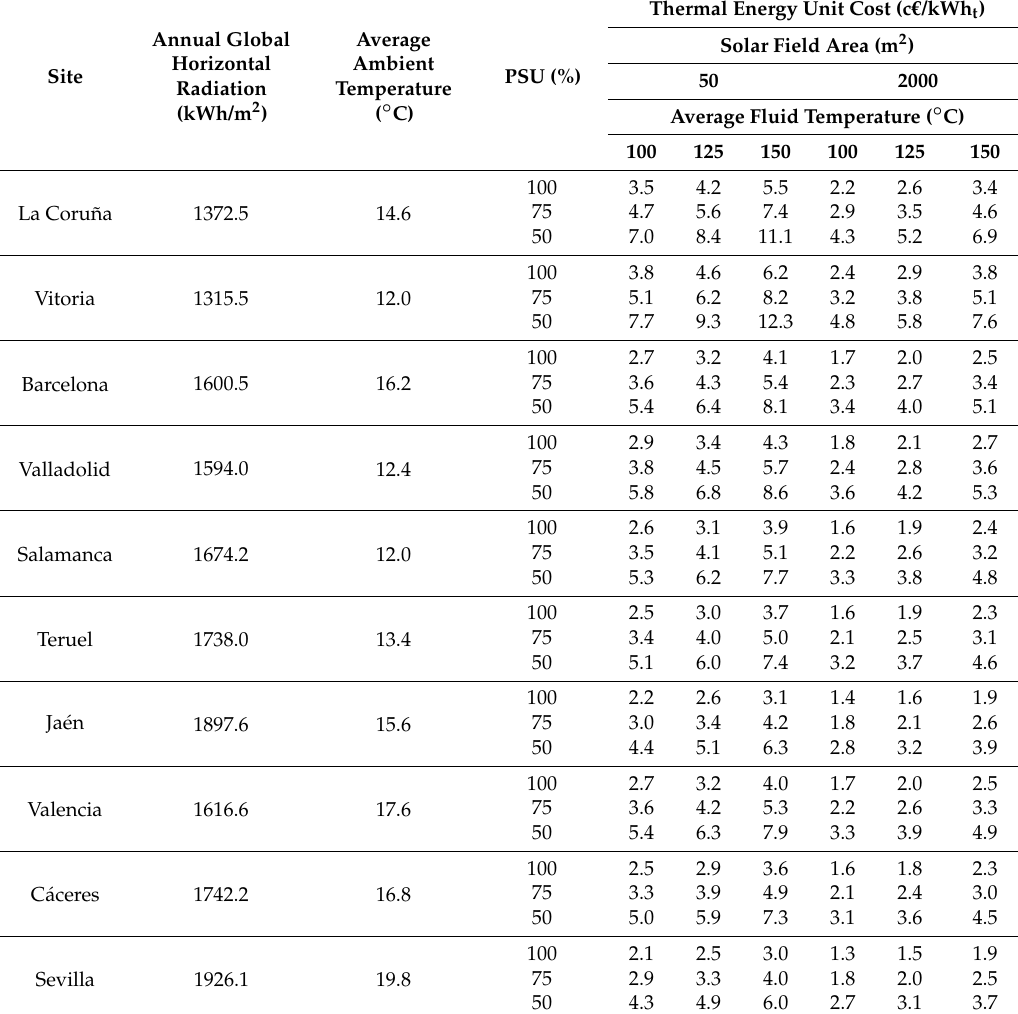
Table 21. Thermal energy unit cost, CPC